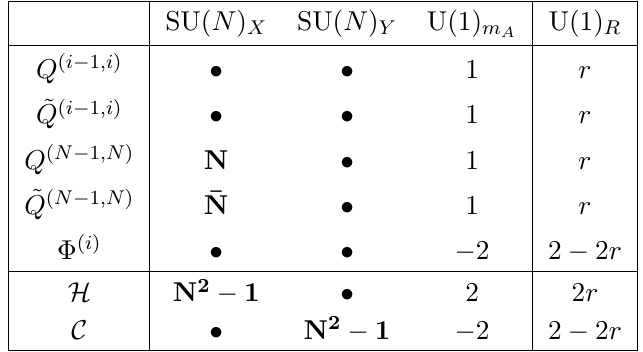
Table 1 . Charges and representations of the chiral (cid:12)elds and of the chiral ring generators of T [SU( N )] under the global symmetries. In the table i = 1 ; (cid:1) (cid:1) (cid:1) ; N (cid:0) 1 and Q (0 ; 1) = ~ Q (0 ; 1) =